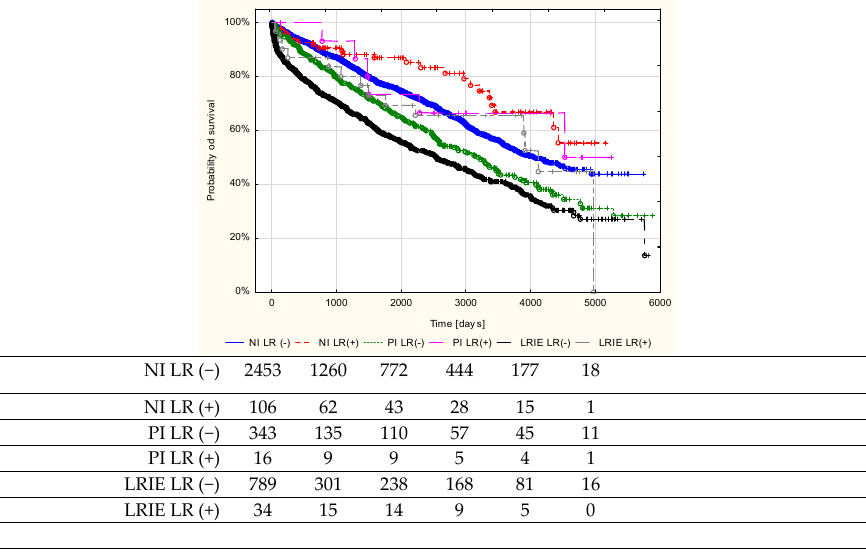
Survival after TLE in patients with non-infectious indications according to the presence or absence of lead remnants after TLE, log rank p = 0.041